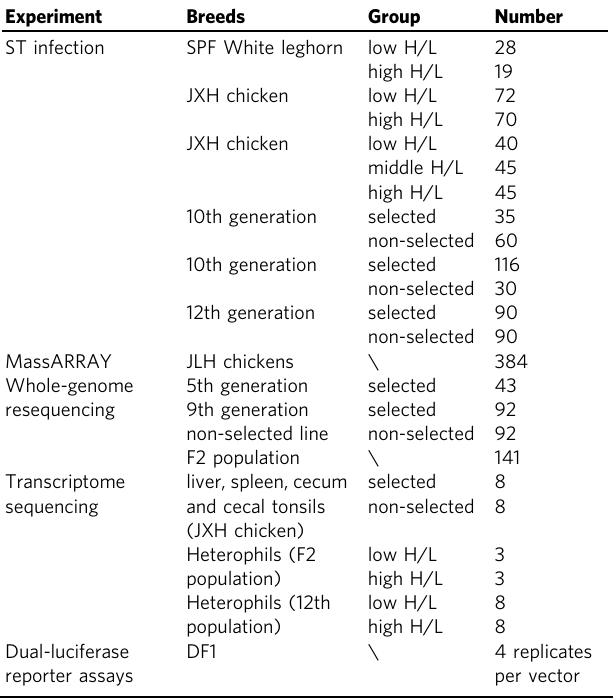
Table 2 Range of sample sizes used in this